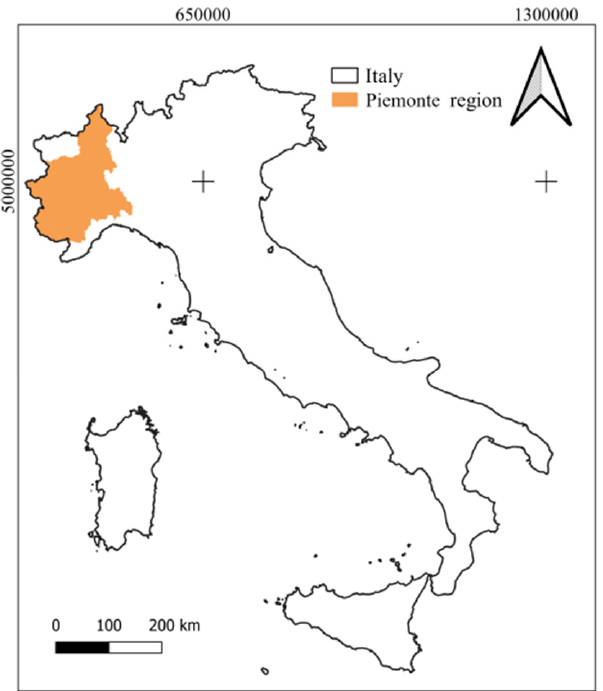
Figure 1. The study area corresponds to the entire Piemonte region (North-West Italy) (Reference frame: WGS 84/UTM zone 32N, EPSG: 32632).